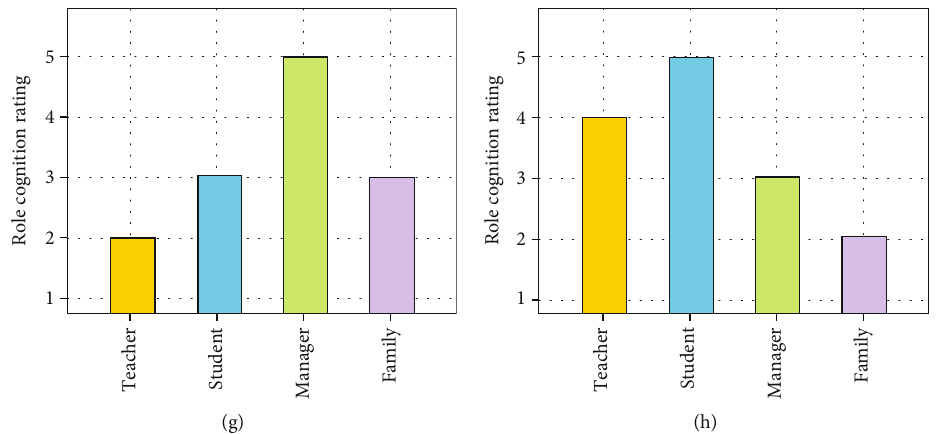
Figure 5: Factor analysis of AI acting on role cognition of all 8 (a) – (h) di ff erent categories in the education system of Taiyuan City. (a) Preschool education, (b) Primary education, (c) secondary education, (d) high education, (e) adult education, (f) network education, (g) enterprise education, and (h) social